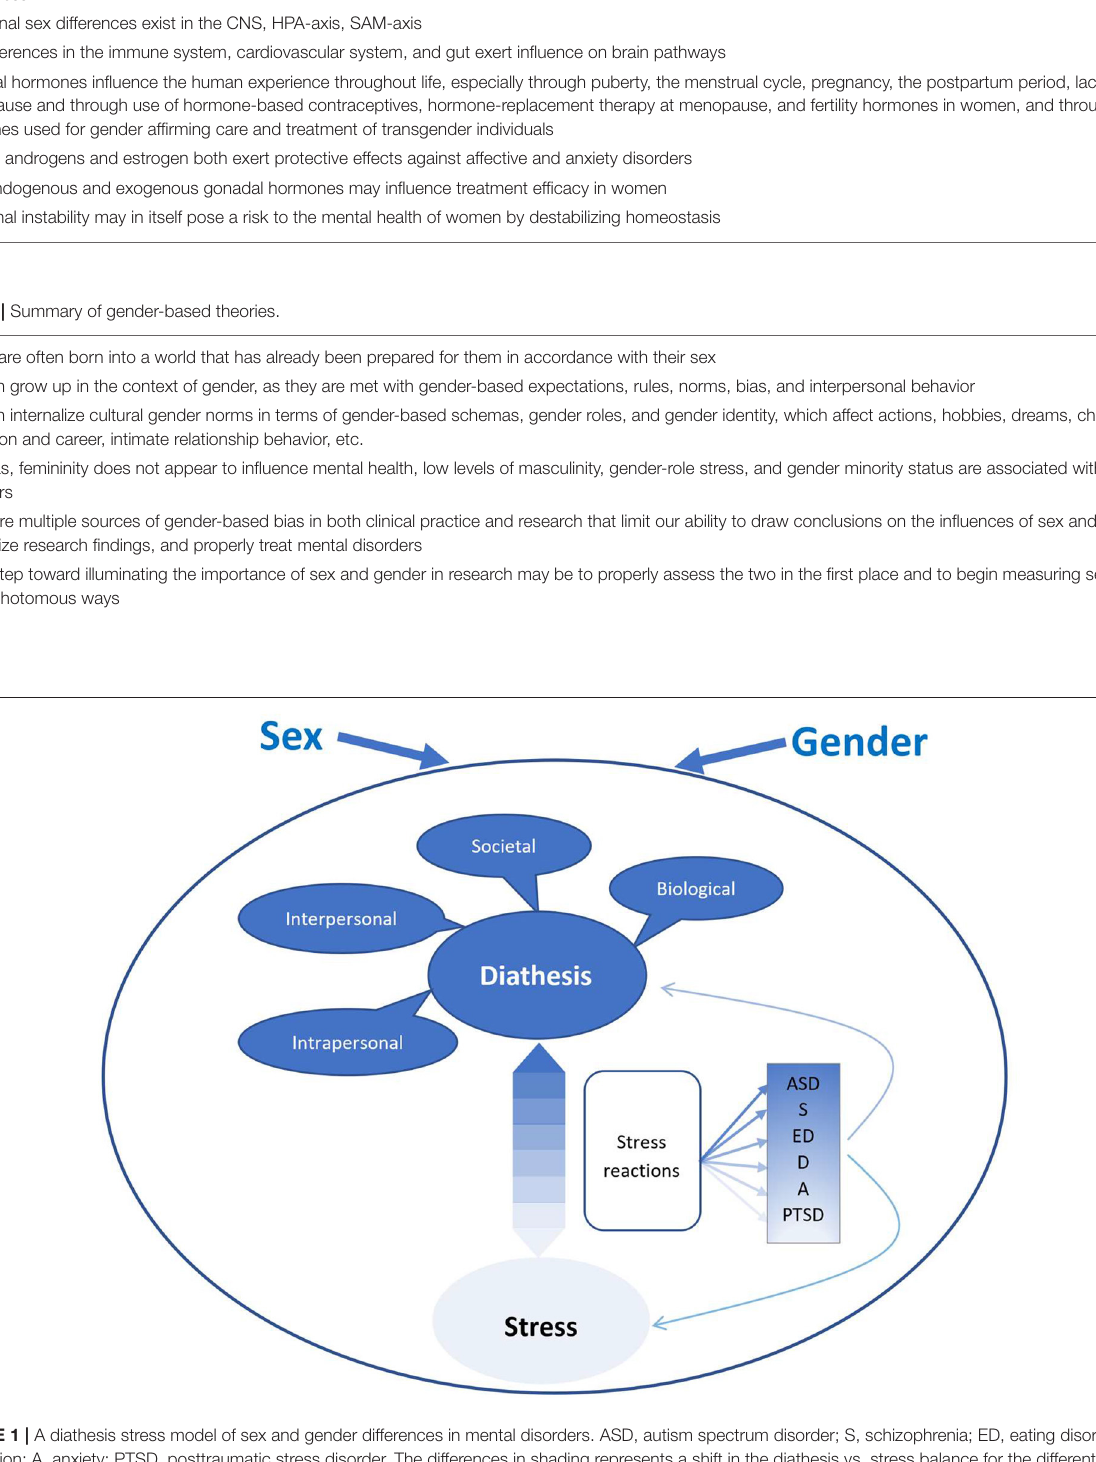
Frontiers in Psychiatry |